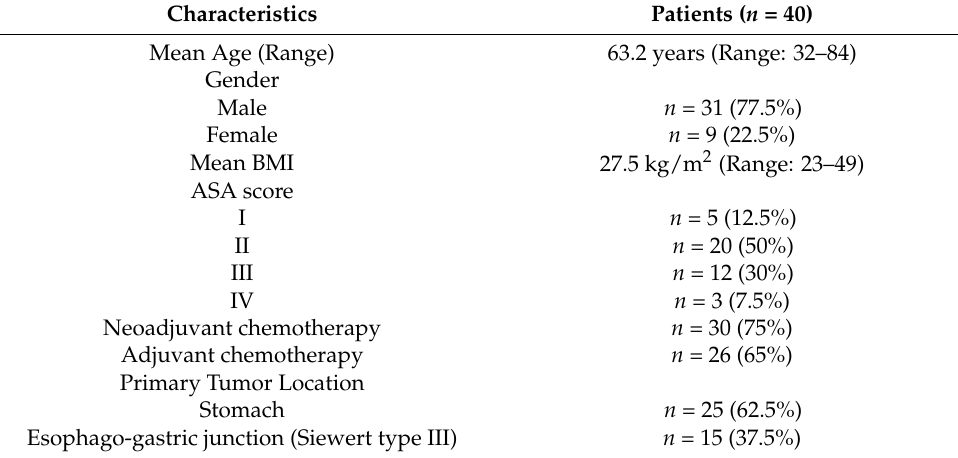
Table 1. Epidemiological and clinical characteristics of the study population.